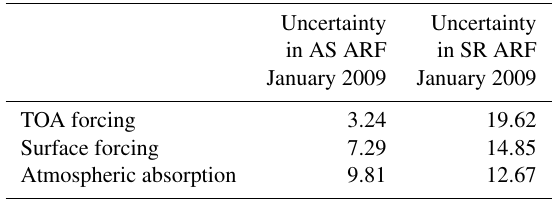
Table A1. The rms uncertainty in direct aerosol radiative forcing over the Indian region for January 2009.